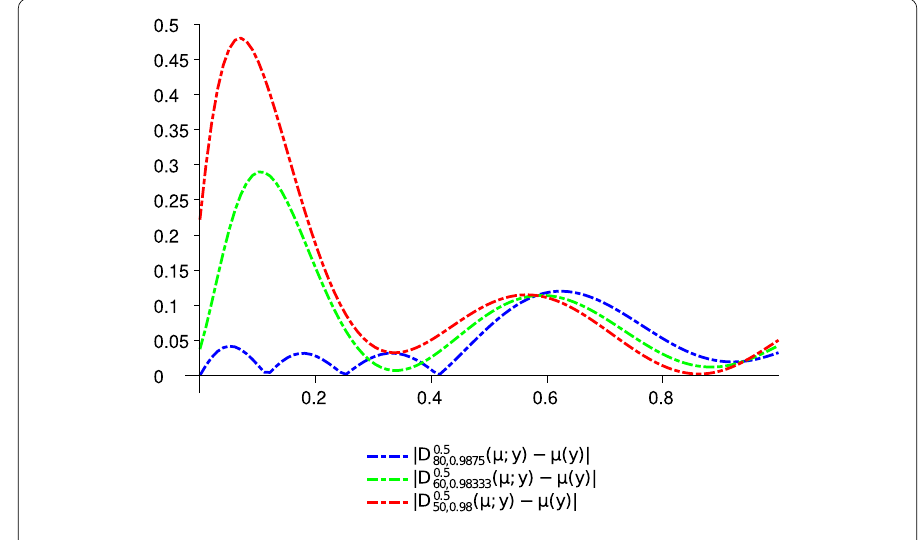
Figure 2 The error of approximation D 0.5 m , q ( μ ; y ) to μ ( y ) for fixed values of q and m